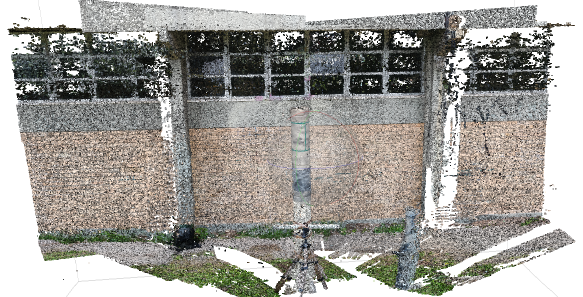
Figure 12. RPA equipped with a stereo vision system performing trajectory “C” (serpentine) for photogrammetric measurement.